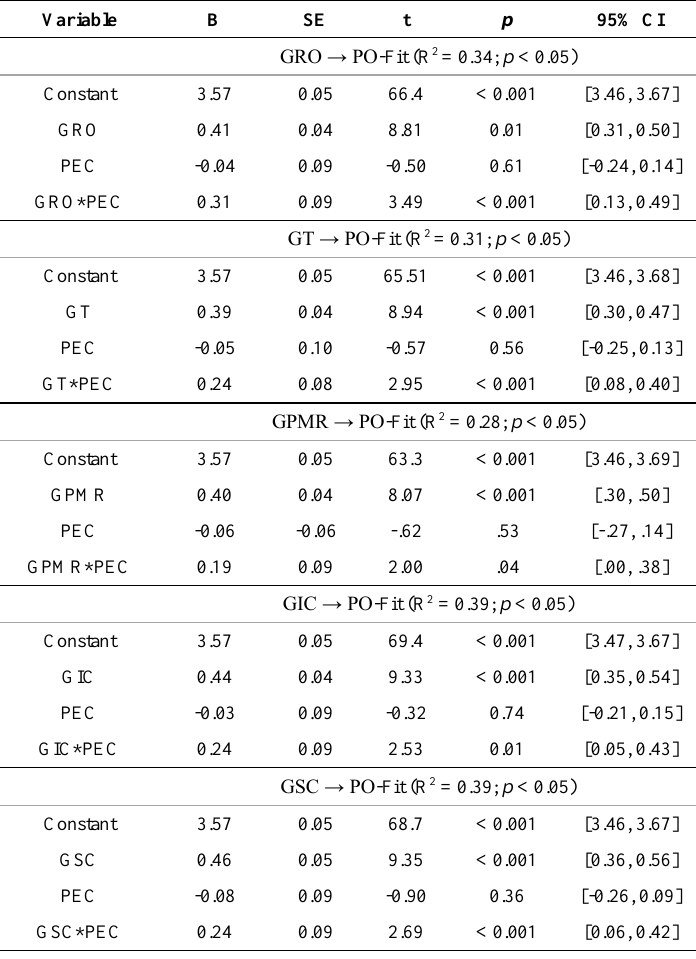
Table 3. Results of the moderation